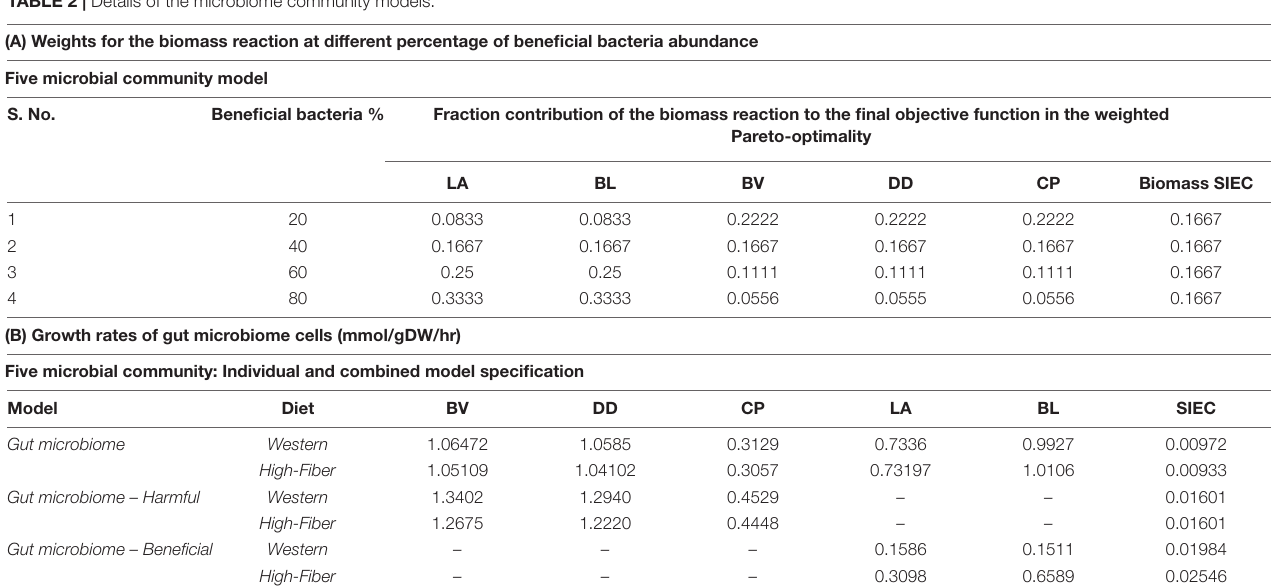
TABLE 2 | Details of the microbiome community